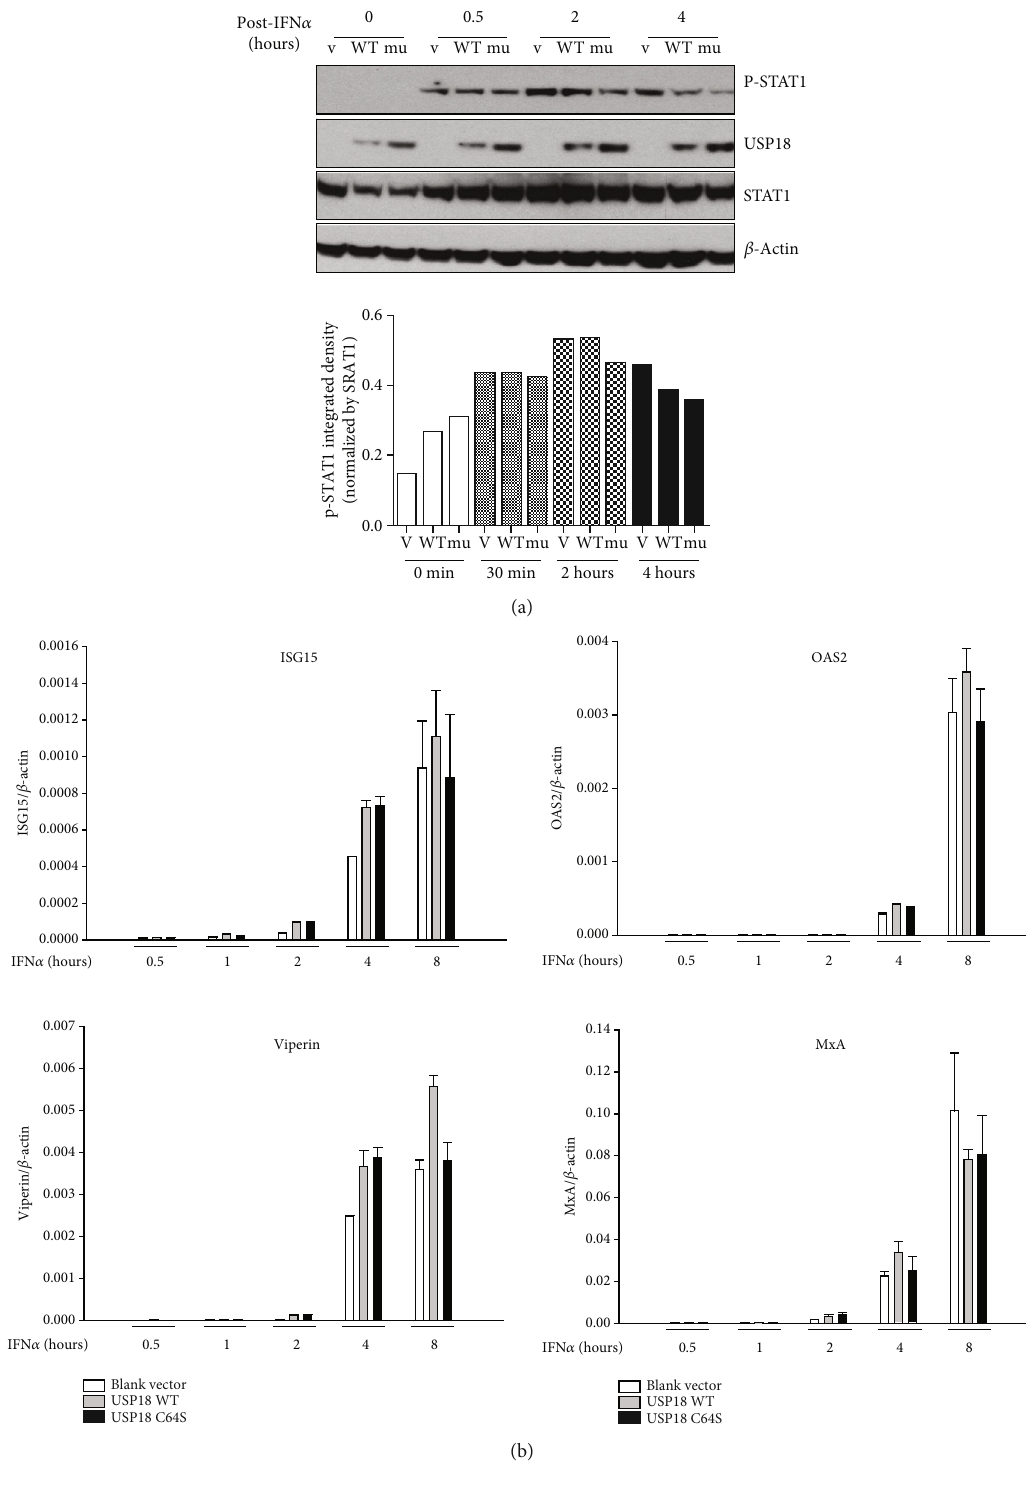
Figure 3: USP18 has no inhibitory e ff ect on Jak/STAT signaling in Huh7.5 cells. Huh7.5 cells were seeded at 3 × 10 5 /ml, 2 ml per well in 6-well plates in antibiotic-free medium for 24 hours before 4 μ g blank vector pcDNA-DEST53, 4 μ g USP18 WT, or 4 μ g USP18 C64S was transfected into each well. 36 hours posttransfection, 100IU/ml IFN α was added to each well. The cells were harvested at 0 min, 30 min, 2 hours, 4 hours, and 8 hours posttreatment. Total protein was extracted to detect USP18, phospho-STAT1 (Tyr701), and total STAT1 by western blot (a, upper), and phospho-STAT1 integrated density was normalized by STAT1 (a, bottom). Total RNA was extracted to detect ISG mRNAs by real-time PCR (b). V: transfected with 4 μ g blank vector pcDNA-DEST53; WT: transfected with 4 μ g USP18 WT; mu: transfected with 4 μ g USP18 C64S. Results are presented as means ± SD ( n ≥ 3